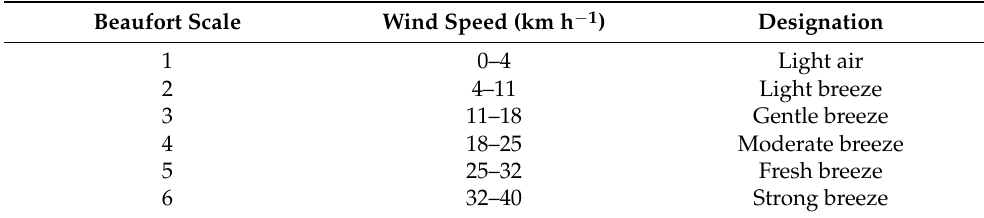
Table 1. Equivalence between the Beaufort scale, wind speed, and standard designation in the studied